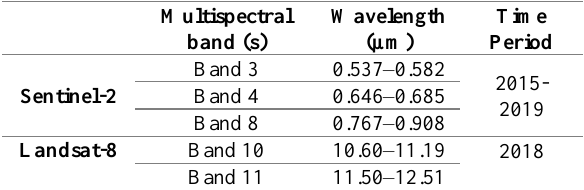
Table 2. Sentinel-2 and Landsat-8 NIR, TIRS